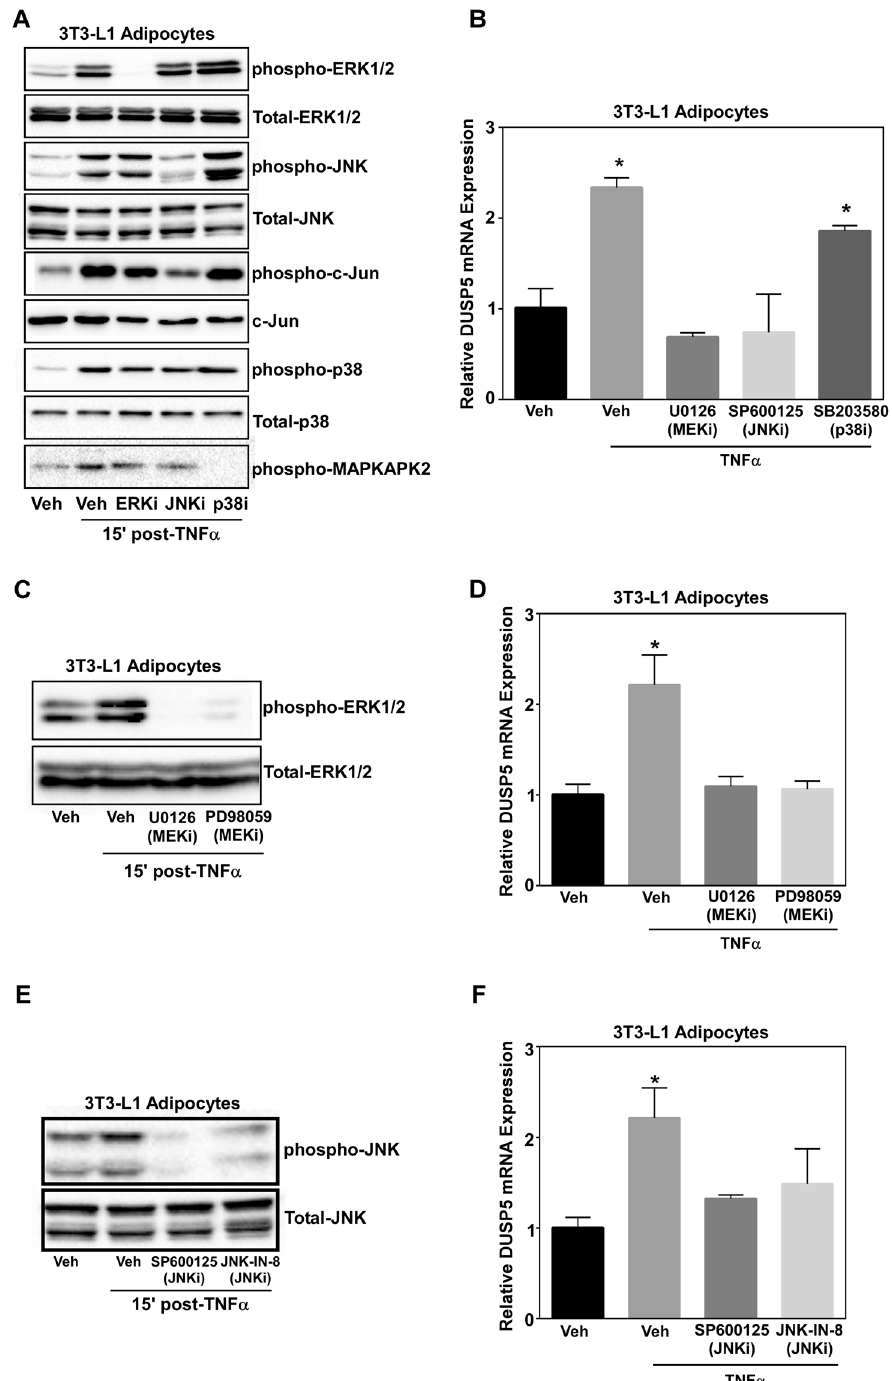
Figure 4. ERK and JNK activity are necessary for TNF α -induced DUSP5 gene expression. Adipocytes were pre- treated with the MEK inhibitor (U0126; ERKi)), JNK inhibitor (SP600125; JNKi) or p38 inhibitor (SB203580; p38i) for 30 min prior to stimulation with 100 pM TNF α . Protein was collected 15 min and RNA isolated 30 min post- TNF α stimulation and ( A ) immunoblotted for phospho-ERK, JNK, p38, c-Jun and MAPKAPK2 as well as total ERK, JNK, p38 and c-Jun. ( B ) DUSP5 mRNA expression was assessed via qPCR. Adipocytes were pre-treated with two independent MEK inhibitors U0126 and PD98059 for 30 min prior to stimulation with 100 pM TNF α . Protein was collected 15 min and RNA isolated 30 min post-TNF α stimulation and ( C ) immunoblotted for phospho- ERK as well as total ERK. ( D ) DUSP5 mRNA expression was assessed via qPCR. Adipocytes were pre-treated with the JNK inhibitors SP600125 or JNK-IN-8 for 30 min prior to stimulation with 100 pM TNF α . ( E ) Protein was collected 15 min post-TNF α stimulation and immunoblotted for phospho-JNK and total JNK. ( F ) RNA was isolated 30 min post-TNF α and qPCR used to examine DUSP5 mRNA expression. ANOVA followed by Tukey’s post-hoc using GraphPad Prism software was used to determine significance p <